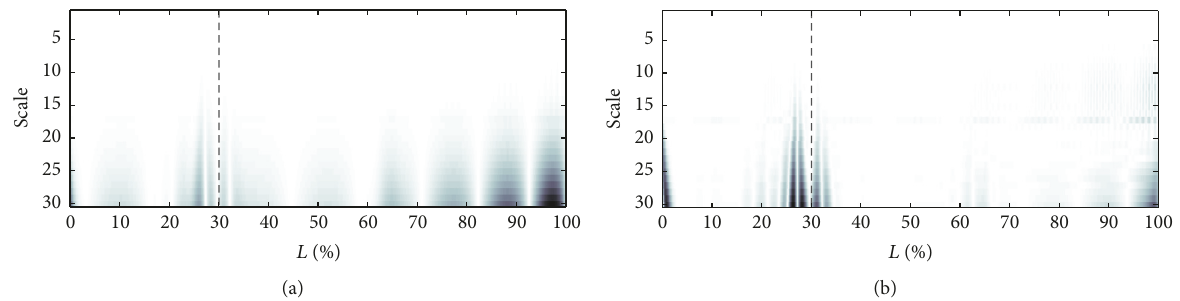
Figure 14: Numerical results of wavelet analysis of the 10th mode of natural vibrations in the case of Gauss4 (a) and Gauss6 (b) wavelet